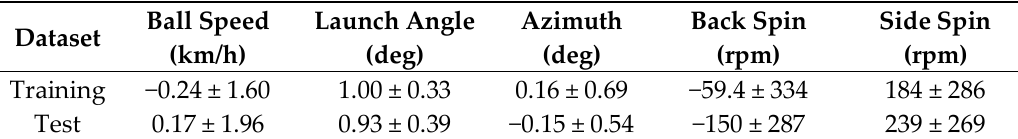
Table 1. Simulated launch condition mean errors and standard deviations for training ( n = 40) and test ( n = 20)